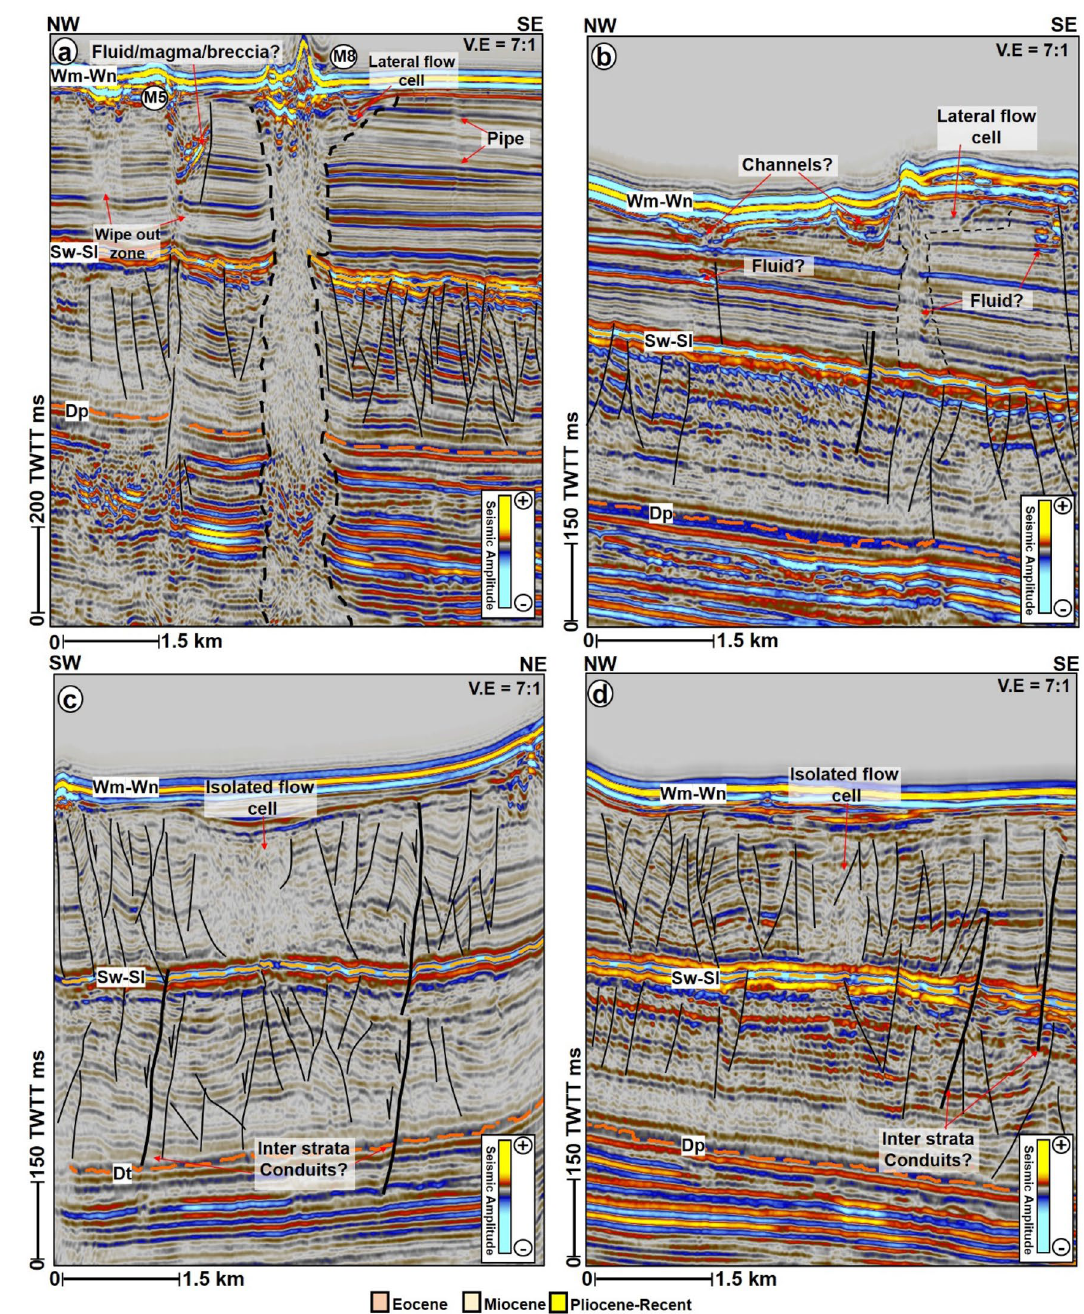
Figure 9. Examples of both vertical and lateral flow cells. ( a ) NW–SE seismic profile showing the interaction of M5 and M8 with other high amplitude anomalies within the Pliocene-Recent strata. In addition, wipe out zones associated with M5 signifying the passage of fluids in the subsurface. ( b ) An example of a lateral flow cell at the northernmost section of M2. Here the link between the Miocene polygonal fault system and the overlying mounds is shown by normal faults connecting both the Miocene and Pliocene-recent strata. ( c ) Along-strike and ( d ) along-dip view of the isolated flow cell shown in Fig. 4. TWTT: Two-way travel time in milliseconds. The uninterpreted seismic sections are provided in the supplementary document mud volcanoes are described as “acoustically transparent” 54,55 . On the contrary, the mounds here (M1-M9) are composed of heterogenous mixture of faulted, high amplitude, moderate to high frequency reflections, are not acoustically transparent and are dominantly cone-shaped. Their conduits also lie above volcanic and basement rocks (Fig. 3), a behaviour that is unlike the archetypical zone of withdrawal below mud volcanoes 8 . Mud vol- canism can hardly explain the conical shape of the mounds and their relationships with underlying volcanic sill intrusions.